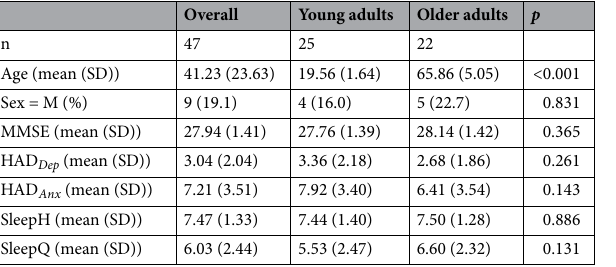
Table 1. Sample descriptive data. MMSE, Mini Mental State Examination; HAD Dep, Hospital Anxiety Scale, Depression subscale; HAD Anx, Hospital Anxiety Scale, Anxiety subscale; SleepH, Hours of sleep; SleepQ, Sleep